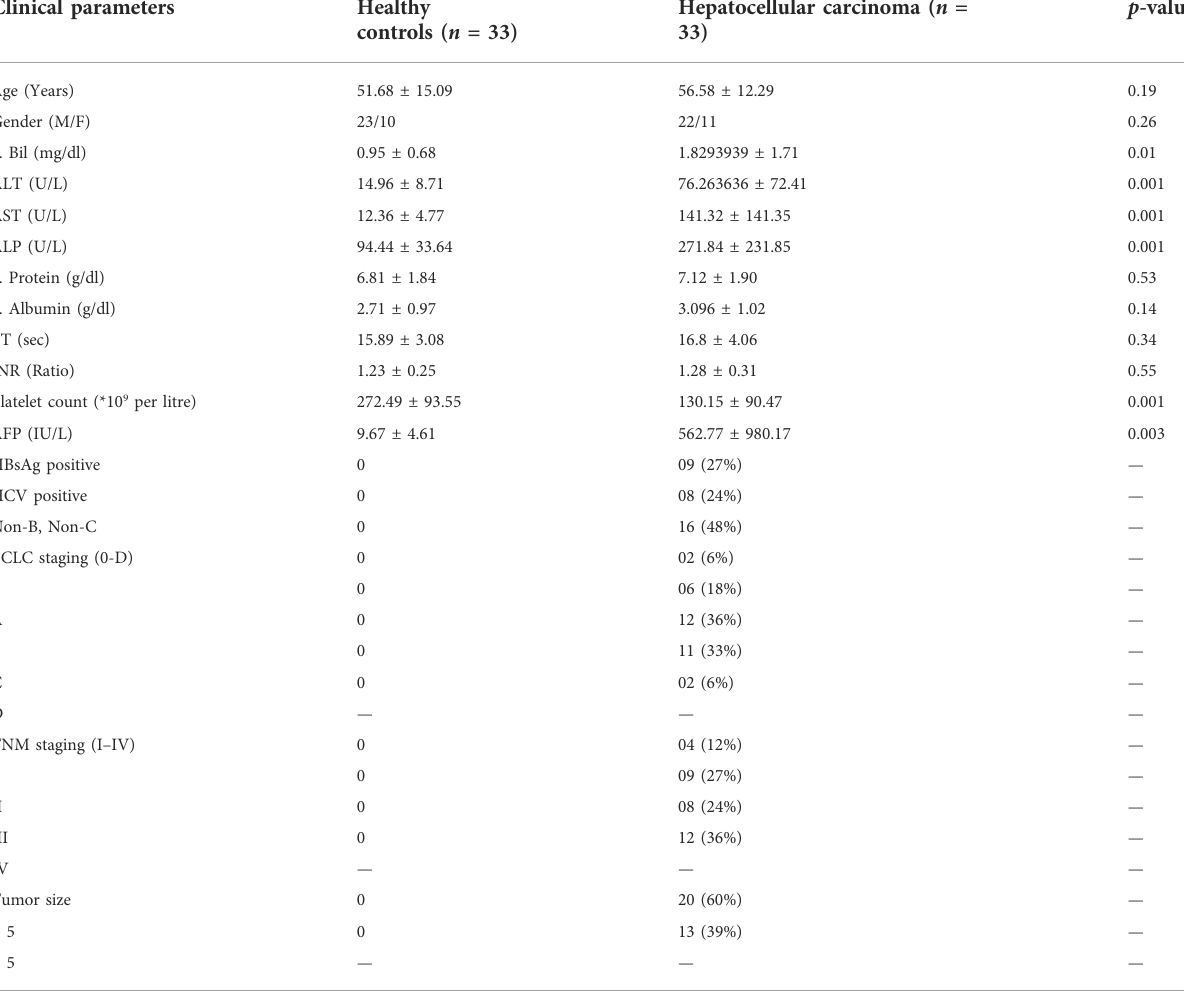
TABLE 1 Clinico-pathological parameters of study subjects: demographics of the two participating groups. Values are expressed as mean ± SD or depicted as the number of cases (%). Data were analyzed using a non-parametric pair t -test (GraphPad Prism 5.0). The statistically signi fi cant p -value was denoted as <